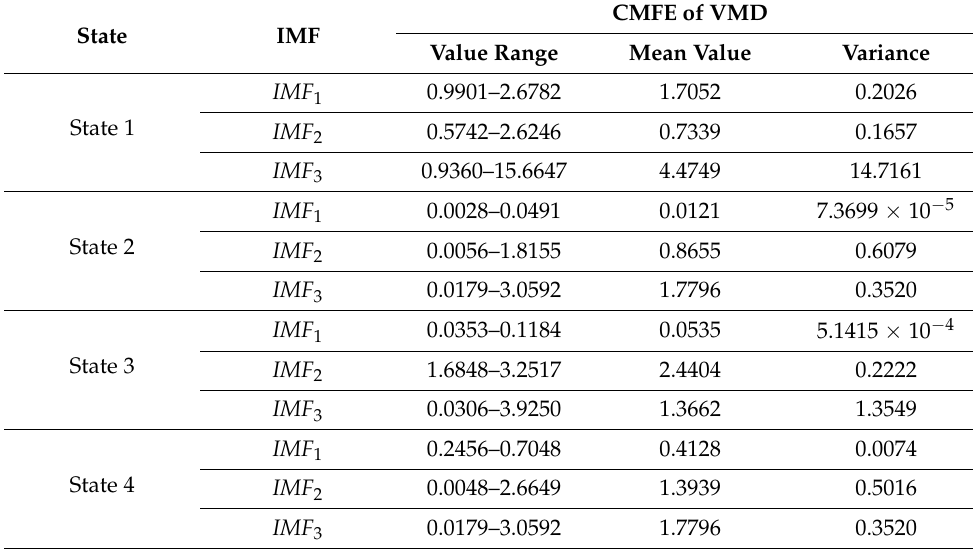
Table 5. CMFE evaluation parameters of VMD in four states.